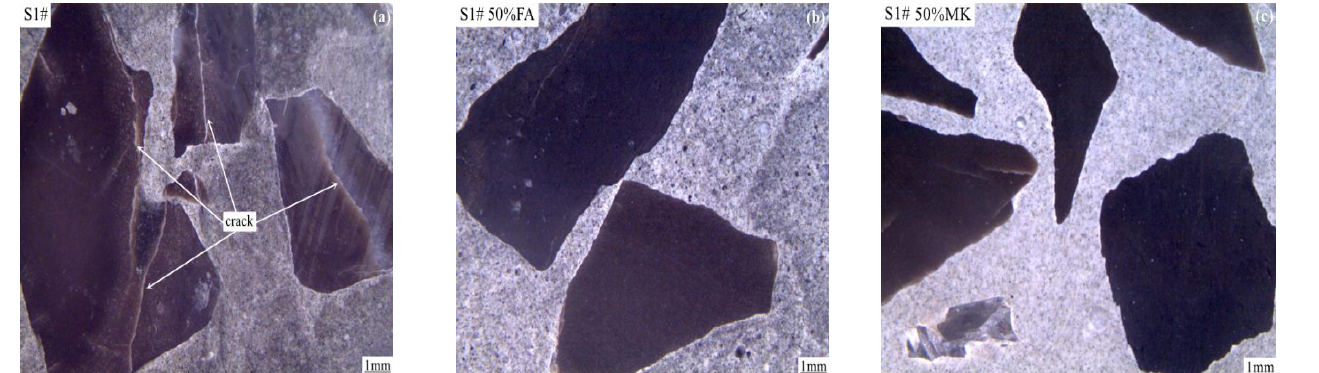
11 of 13 Figure 11. SEM image of the product in fracture surface of aggregate S1# in the concrete microbars cured in 1M NaOH solution at 80 °C for 28 days: ( a ) 50% metakaolin. ( b ) 50% fly ash. 3.7. Effects of Fly Ash and Metakaolin on Expansion Cracks Figure 12 shows the expansion cracks of concrete microbars prepared with rock S1# cured in 1M NaOH solution at 80 °C for 56 days. As can be seen from Figure 12a, obvious cracks appeared inside the concrete microbars without fly ash and metakaolin, and these cracks were mainly concentrated in the rock aggregate, from the inside of the rock to the